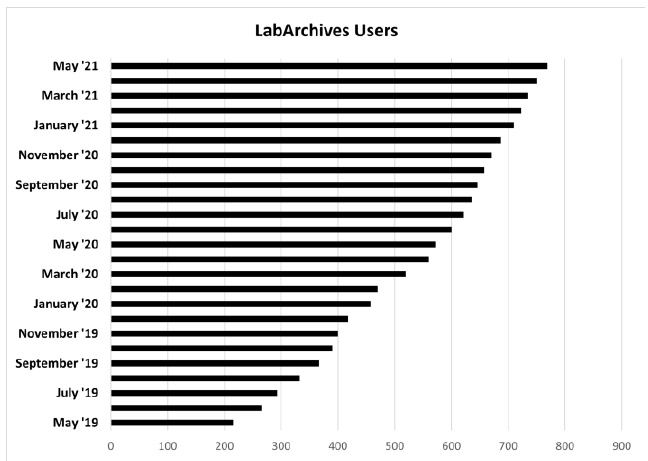
Figure 1 Number of LabArchives users May 2019 – May